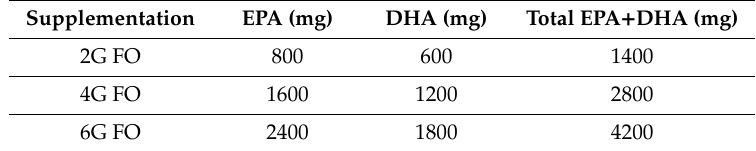
Table 2. Eicosapentaenoic acid and docosahexaenoic acid totals per day of supplementation for each fish oil supplemented